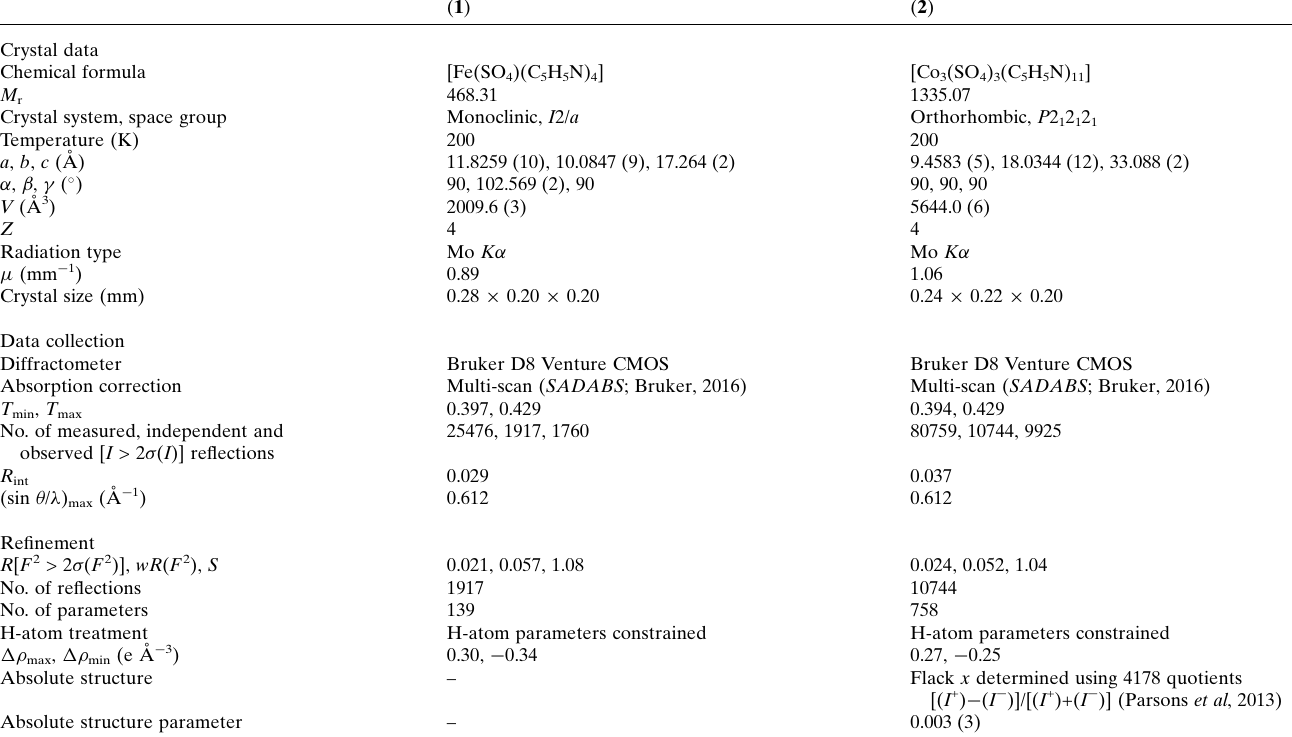
Table 3 Experimental details.